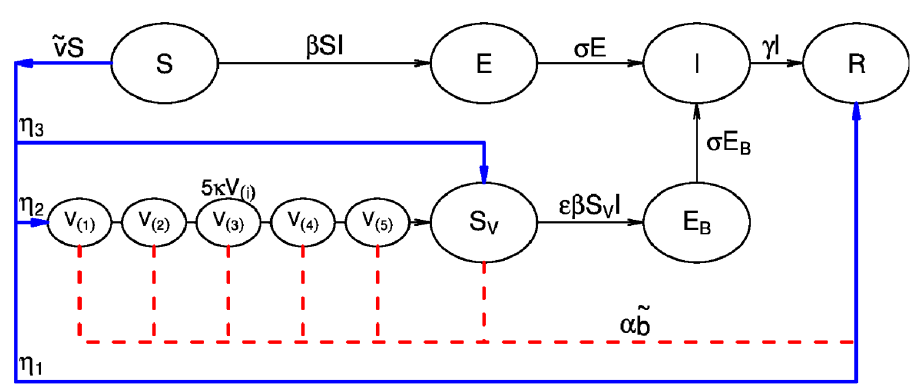
Fig 2. A flowchart of Susceptible-Exposed-Infective-Recovered-Vaccinated (SEIRV) model for one age group. Susceptible individuals flow through the compartments in linear order: S ! E ! I ! R . Vaccinated susceptible individuals are of three immunity types: a proportion ( η 1 ) move directly to the Recovered class and gain long-term protection; a proportion ( η 2 ) gain medium-term temporary protection and move through a series of five V ( k ) classes. class. Individuals in S are susceptible to After a period in which immunity wanes, they then move on to the S V V breakthrough infections and move to the E B and I class; a proportion ( η 3 ) of those vaccinated have little protection and move to S class directly. A proportion of individuals in V ( and S receive the booster dose and move to the R class. V k ) V Bold blue lines indicate full vaccination (second dose) and dashed red lines indicate booster vaccination.